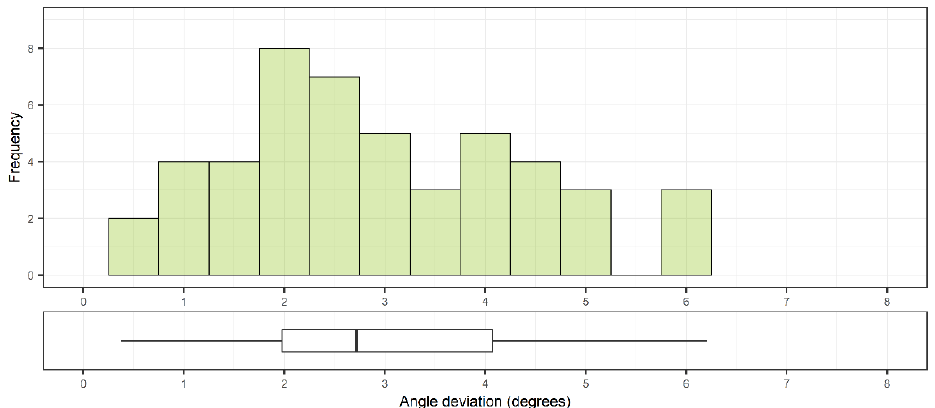
Figure 6. Distribution of angular deviations between planned trajectories and placed screws (n = 48) with corresponding box plot indicating median and interquartile range.